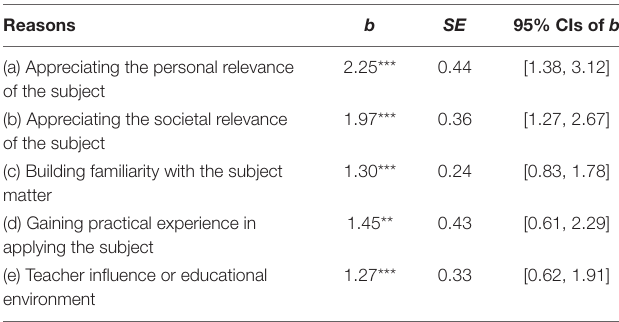
TABLE 1 | Students’ reasons for why their passion had increased over time ( N = 128).